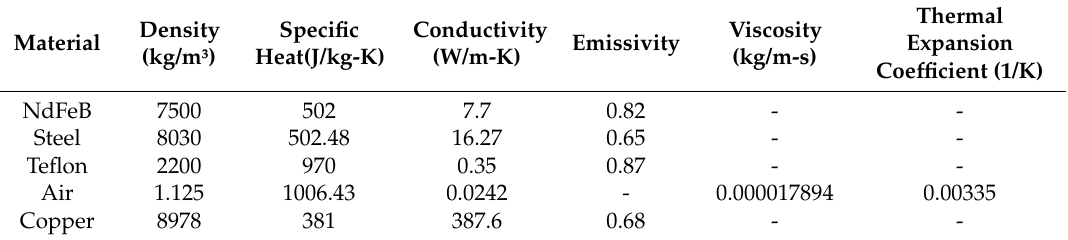
Table 3. Thermal properties of actuator materials and air used in thermal simulation.